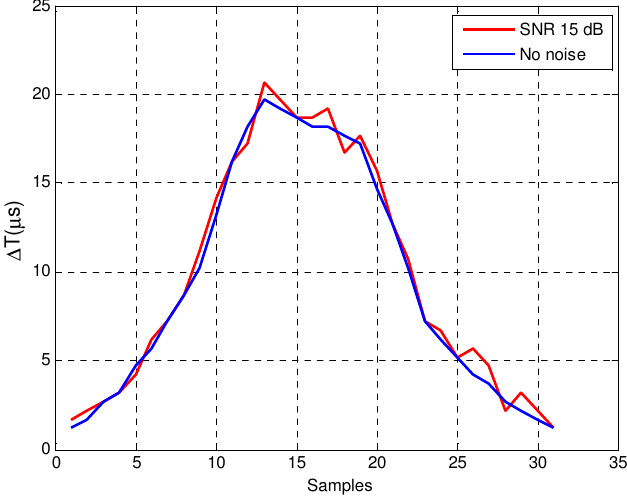
Figure 15. Inductive signature of the resonant detector with and without noise.